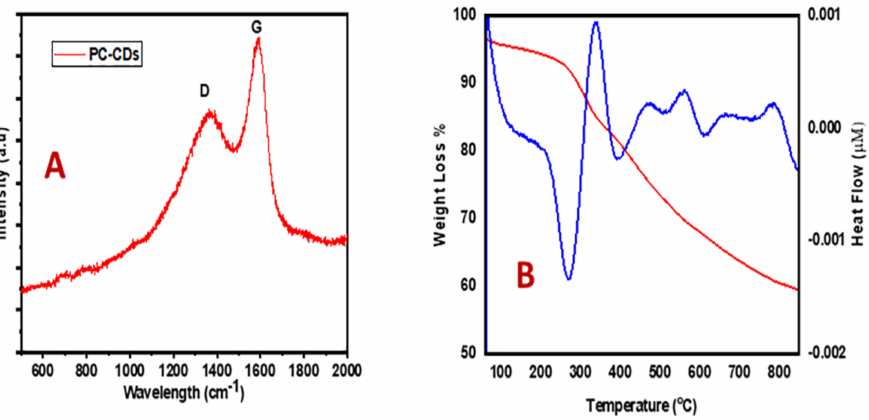
Figure 2. ( A ) Raman spectrum and ( B ) TGA (Red) and DSC (Blue) curves of synthesized